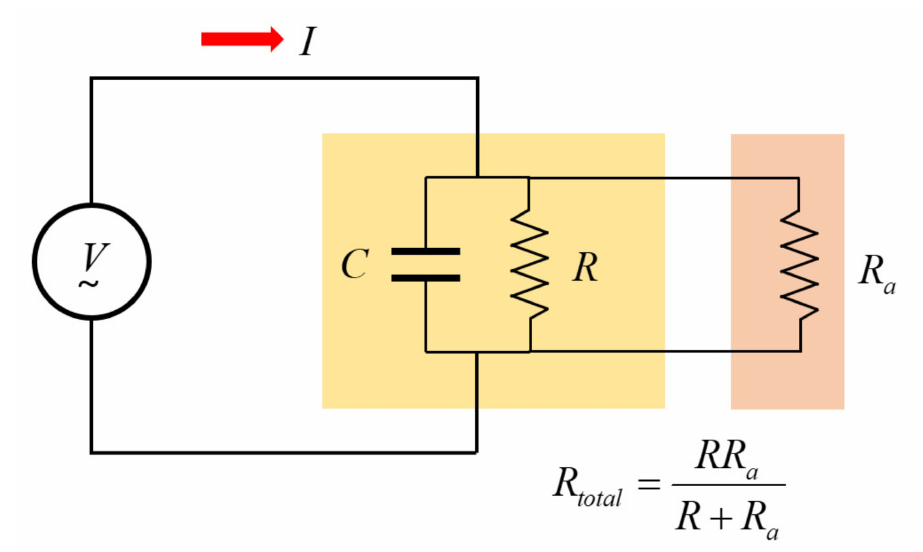
Figure 6. Parallel RC circuit with additional resistors connected.